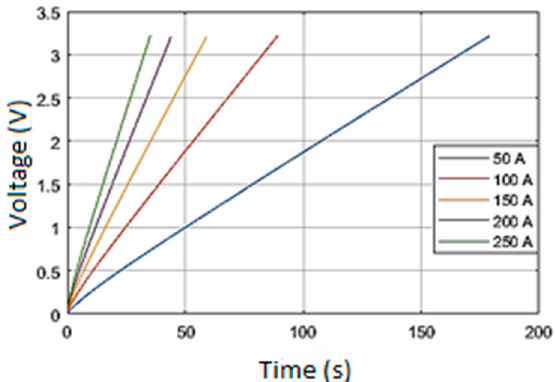
Figure 6. Charging characteristics of 3.0 V/3000 F SC cell of the proposed model [17].